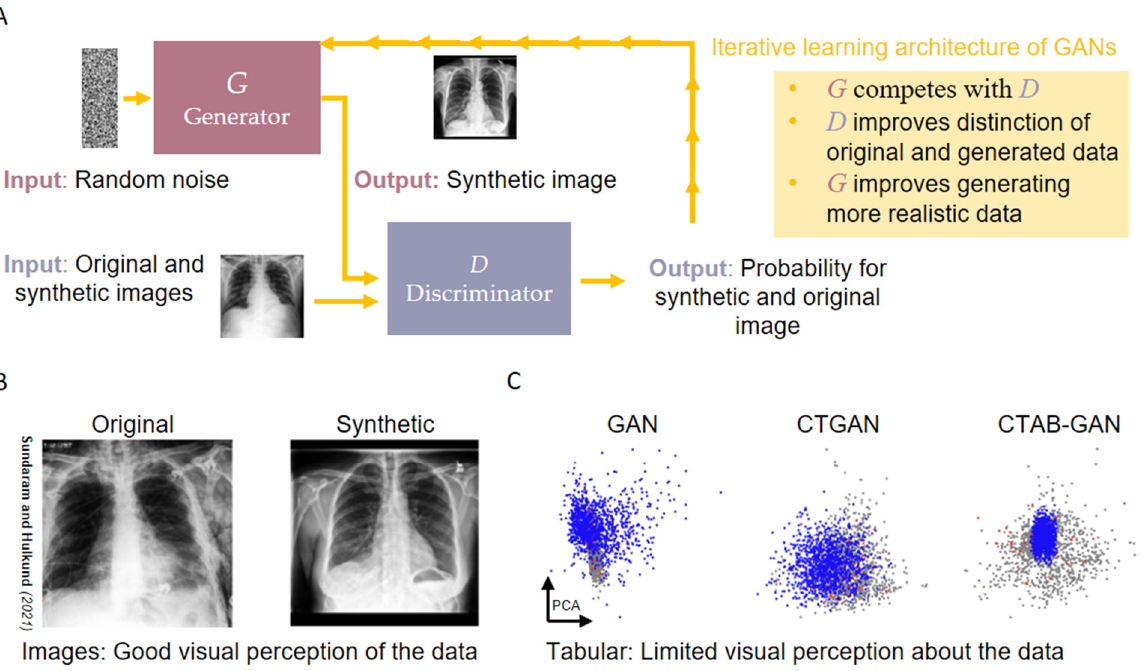
Figure 1. Main principle of the GAN architecture. ( A ) Refers to the iterative learning principle of Generative Adversarial Networks (GANs) using two Neural Networks (Generator G, and Discriminator D). ( B ) Shows examples of synthetically generated images, adapted from Sundaram and Hulkund [64]. ( C ) Shows a current example of a current benchmark for synthetic tabular data, adapted from Schultz et al. [65].